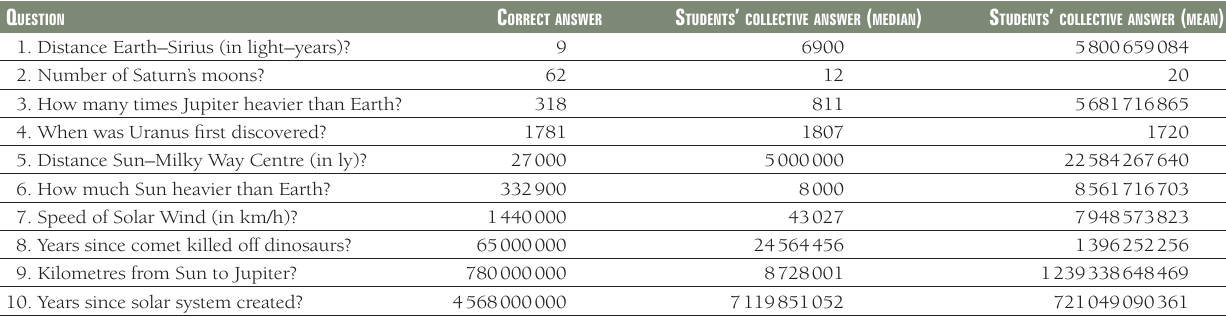
Table 5. Year 2 undergraduate medical students’ collective answers to the 10 questions in the area outside of their expertise (astronomy) Q